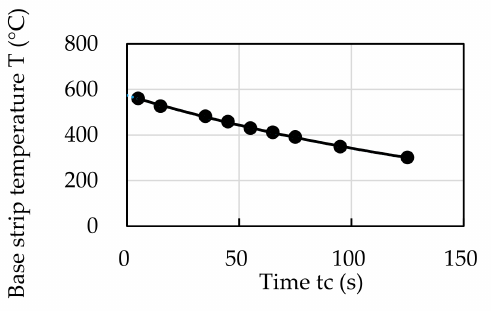
Figure 3. Relationship between the time after the base strip was released from the first caster and the temperature of the strip.